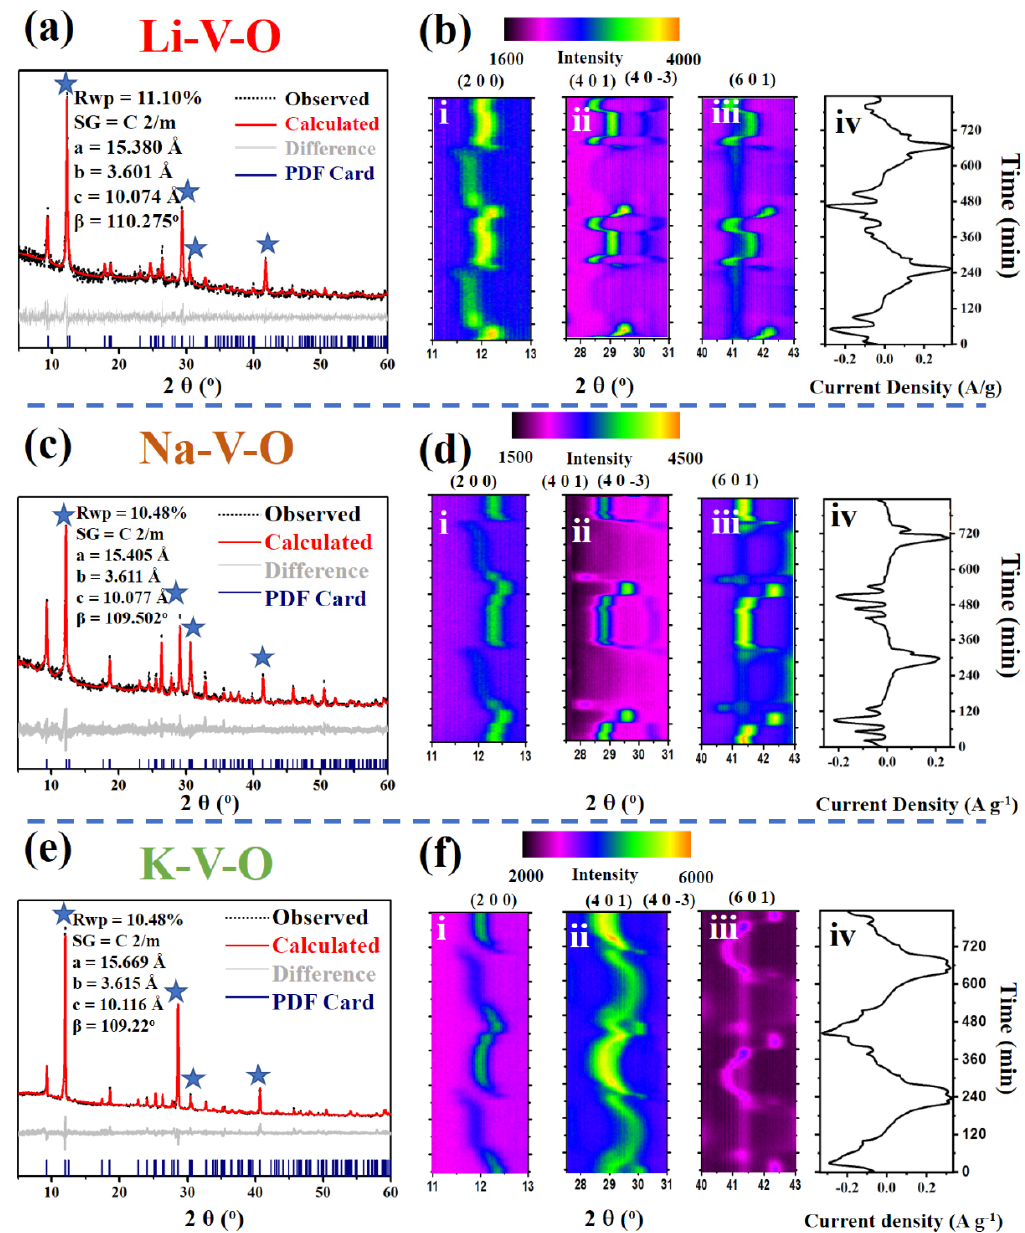
Figure 2. Refined XRD patterns and in situ cyclic voltammetry measurements of Li-V-O ( a , b ), Na-V-O Figure 2 . Refined XRD patterns and in situ cyclic voltammetry measurements of Li-V-O (a, b), Na- 180 ( c , d ), and K-V-O ( e , f ) at a scan rate of 0.2 mV/s. V-O (c, d), and K-V-O (e, f) at the scan rate of 0.2 mV/s. 181 Li-V-O (Figure 2(b-iv)) and Na-V-O (Figure 2(d-iv)) present nearly the same in situ For Li-V-O and Na-V-O, in the CV curves four distinct cathodic peaks located at about 3.2, 2.8, 2.3 182 CV curves compared with K-V-O (Figure 2(f-iv)), where there are several pairs of obvious and 1.9 V (Figure 2b-iv, 2d-iv, Figure S6b and S6c) corresponding to four electrochemical reactions 183 redox peaks compared with the inconspicuous ones. The 2D XRD patterns of Li-V-O are observed. Firstly, as the anodic process goes, when the voltage reaches 3.2 V (Figure S6), all the 184 (Figure 2(b-i–iii)) and Na-V-O (Figure 2(d-i–iii)) show nearly the same variation trend in selected XRD peaks (Figure 2b i-iii and 2f i-iii) of Li-V-O and Na-V-O continuously shift to the lower 185 contrast with that of K-V-O (Figure 2(f-i–iii)). Here, the phase transitions of Li-V-O and two theta angles. It can be concluded the four diffraction planes (200), (401), (40 3(cid:3364) ) and (601) present 186 Na-V-O are discussed a slight expansion of the interlayer and intralayer spacing. Further analysis proves half of the M3 187 sites are occupied preferentially with 0 < x < 0.33 to form the Li x Li 0.33 V 2 O 5 and Li x Na 0.33 V 2 O 5 (Figure 188 S10 and S11, Supporting Information). The formed Li 0.33 V 2 O 5 during lithium intercalation is not a 189 very stable phase, it forms under specific current and potential. As for Li-V-O, during the prepara- 190 tion the Li-V-O is sintered, thus makes it a very stable phase. Secondly, with more Li ions interca- 191 lated (0.33 < x <0.66), those peaks mentioned above make an abrupt or discontinuous shift to a higher 192 angle till about 2.8 V, indicating a significant contraction of the interlayer and intralayer spacing 193